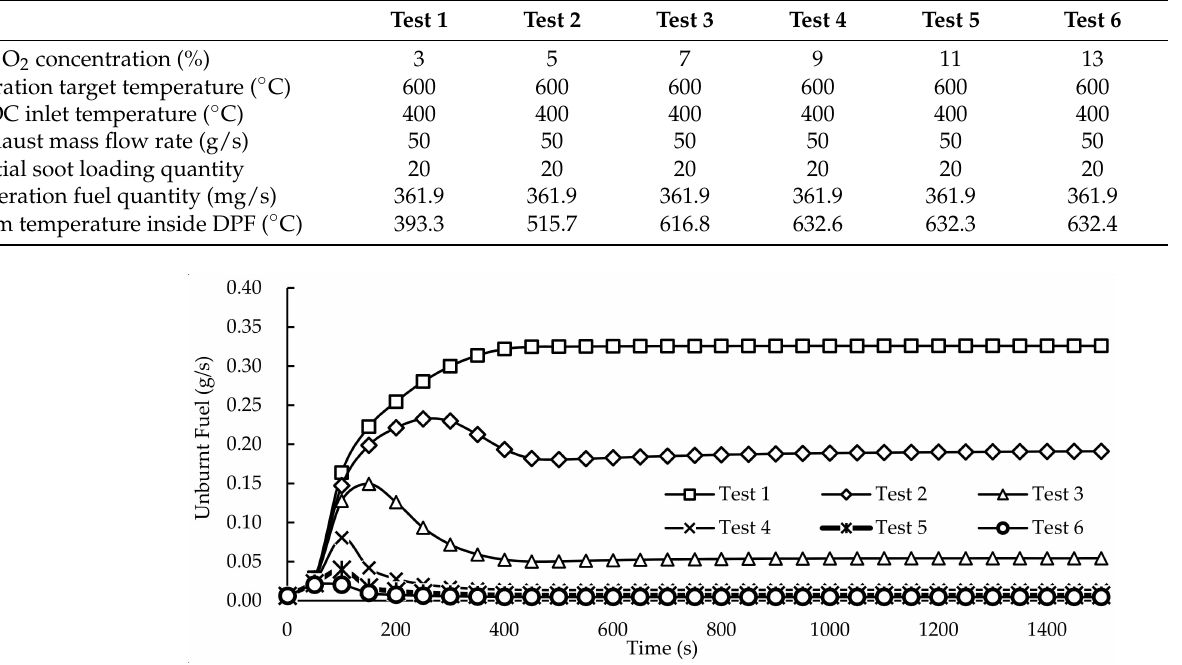
Table 8. Regeneration analysis with different oxygen concentrations.